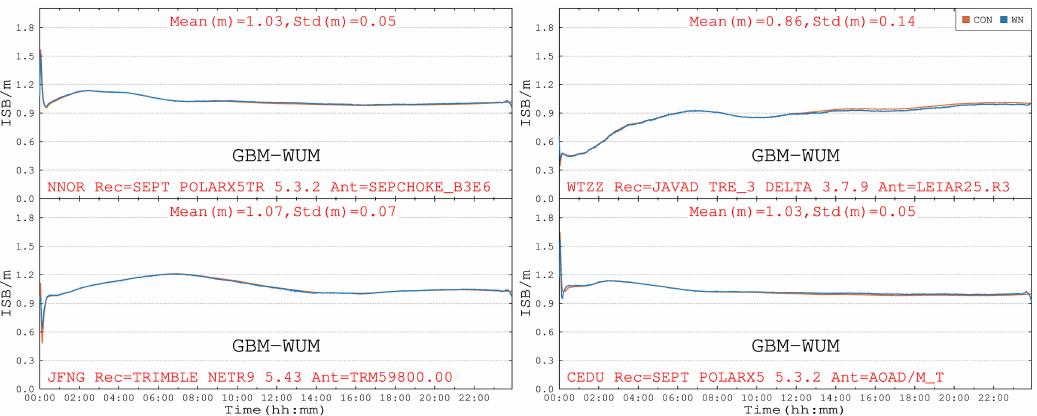
Figure 6. The epoch di ff erence of ISB between GBM and WUM precise products at DOY 110, 2020 for CEDU, JFNG, NNOR, and